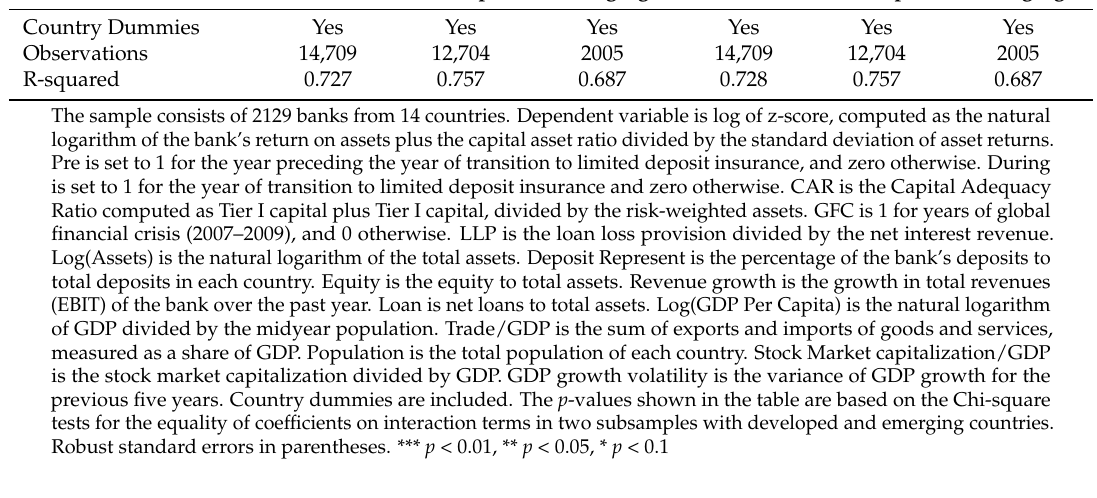
Table 6. The immediate effect of reduction in deposit insurance, capital adequacy, and bank risk—earning